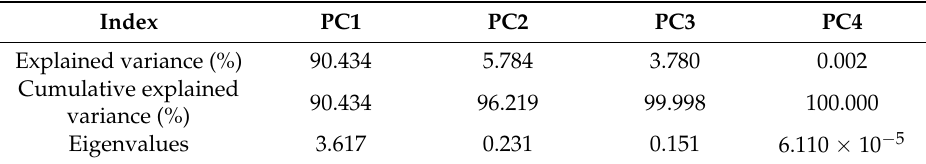
Table 2. Principal component analysis (PCA)